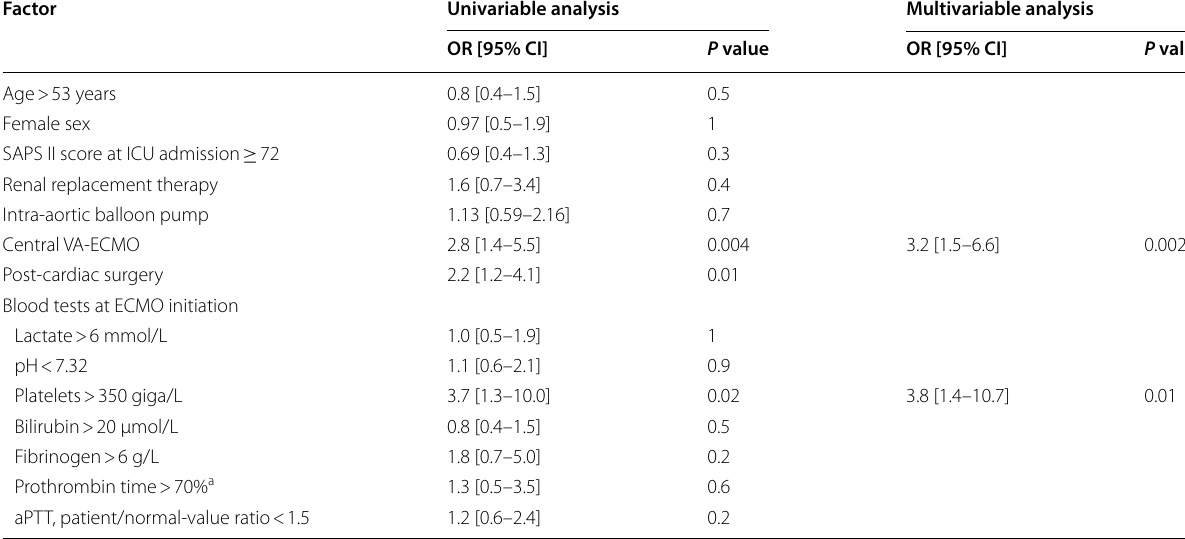
VA-ECMO venoarterial-extracorporeal membrane oxygenation, OR odds ratio, SAPS Simplified Acute Physiology Score, ICU intensive care unit, aPTT activated partial thrombin time a Expressed as a percentage of the normal value